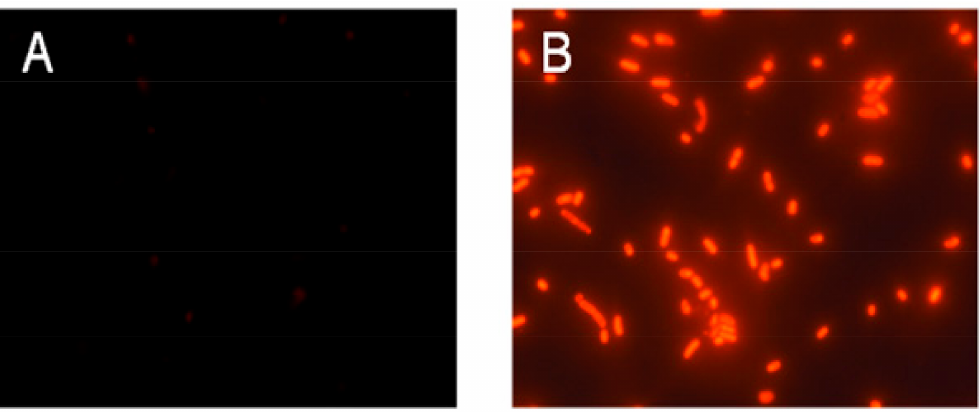
Figure 4. Effect of HJH-1 on Escherichia coli membrane permeability. ( A ) E. coli was incubated with phosphate buffer saline (PBS) PBS (control) for 30 min. ( B ) E. coli was incubated with HJH-1 (1 × MIC) for 30 min.